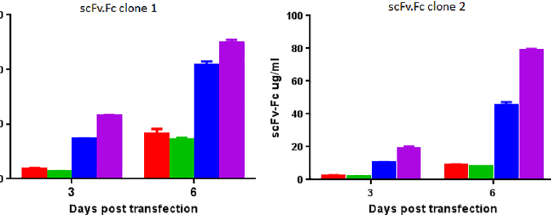
Fig 4. Expression levels of scFv.Fcs in mammalian cells. Octet based quantitation of expression level at day 3 and 6 post-transfection of scFv.Fc clone 1 and 2 from pSplice version 2 (red), 3 (green), 4 blue) and 5 (magenta) vectors. The mean values for each group are derived from experiments done in triplicates and the s.d. is represented by error bars.